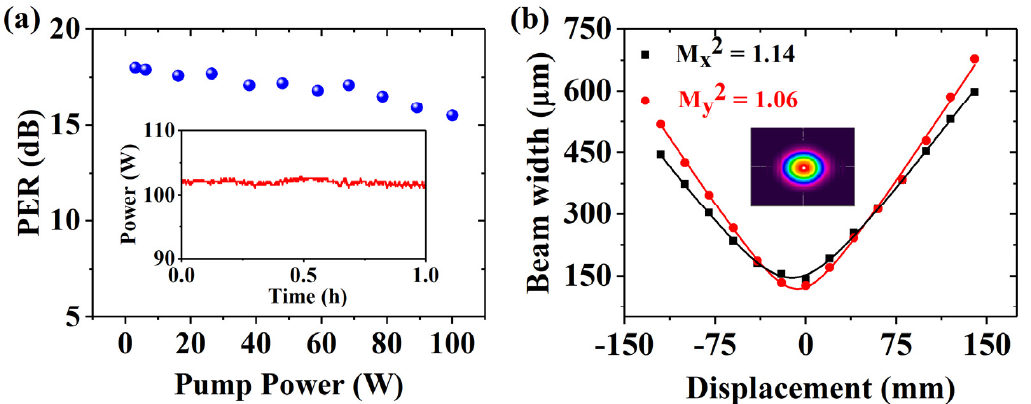
Figure 5. The system is under 940 nm LD pumping and 6 W input signal power. ( a ) PER of 1560 nm linearly-polarized SFFL versus the output power. Inset: Power stability at one hour at maximum output power. ( b ) Measured beam quality factors M 2 and far-field beam profile at the output power of 102 W.